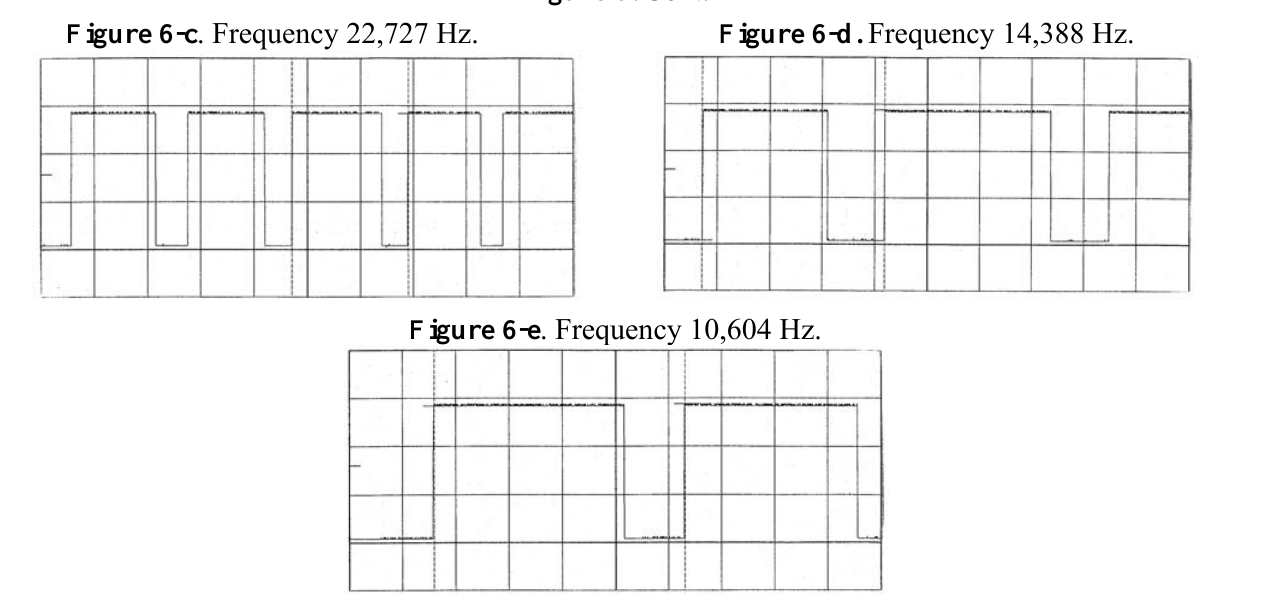
Figure 6. Cont. Figure 6-c . Frequency 22,727 Hz. Figure 6-d. Frequency 14,388 Hz.